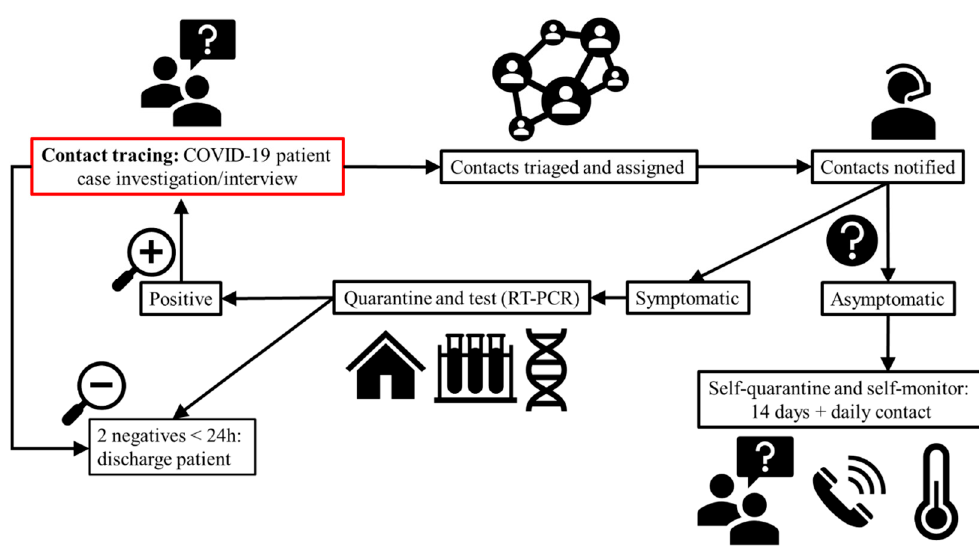
Figure 2. Contact tracing workflow for probable COVID-19 patients. Adapted from CDC [94,95] and WHO [71,96].